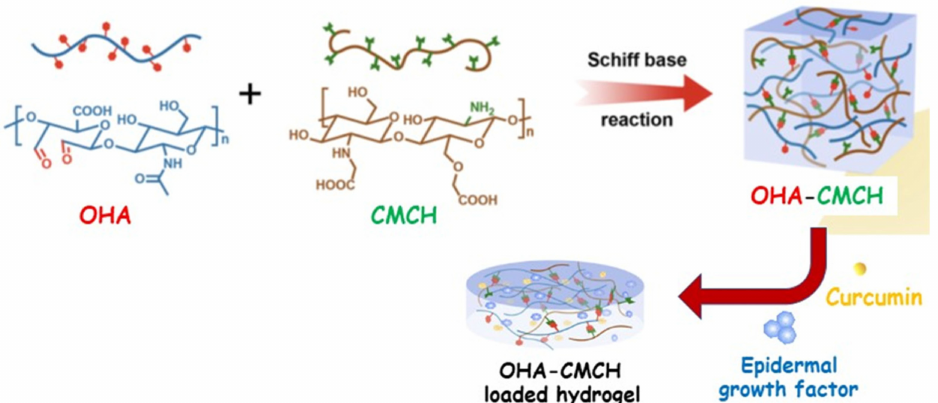
Figure 5. Schematic representations of the oxidized hyaluronic acid-carboxymethyl chitosan (OHA- CMCH) curcumin and epidermal growth factor loaded hydrogel fabricated via the reversible Schiff base reaction between OHA and CMCH